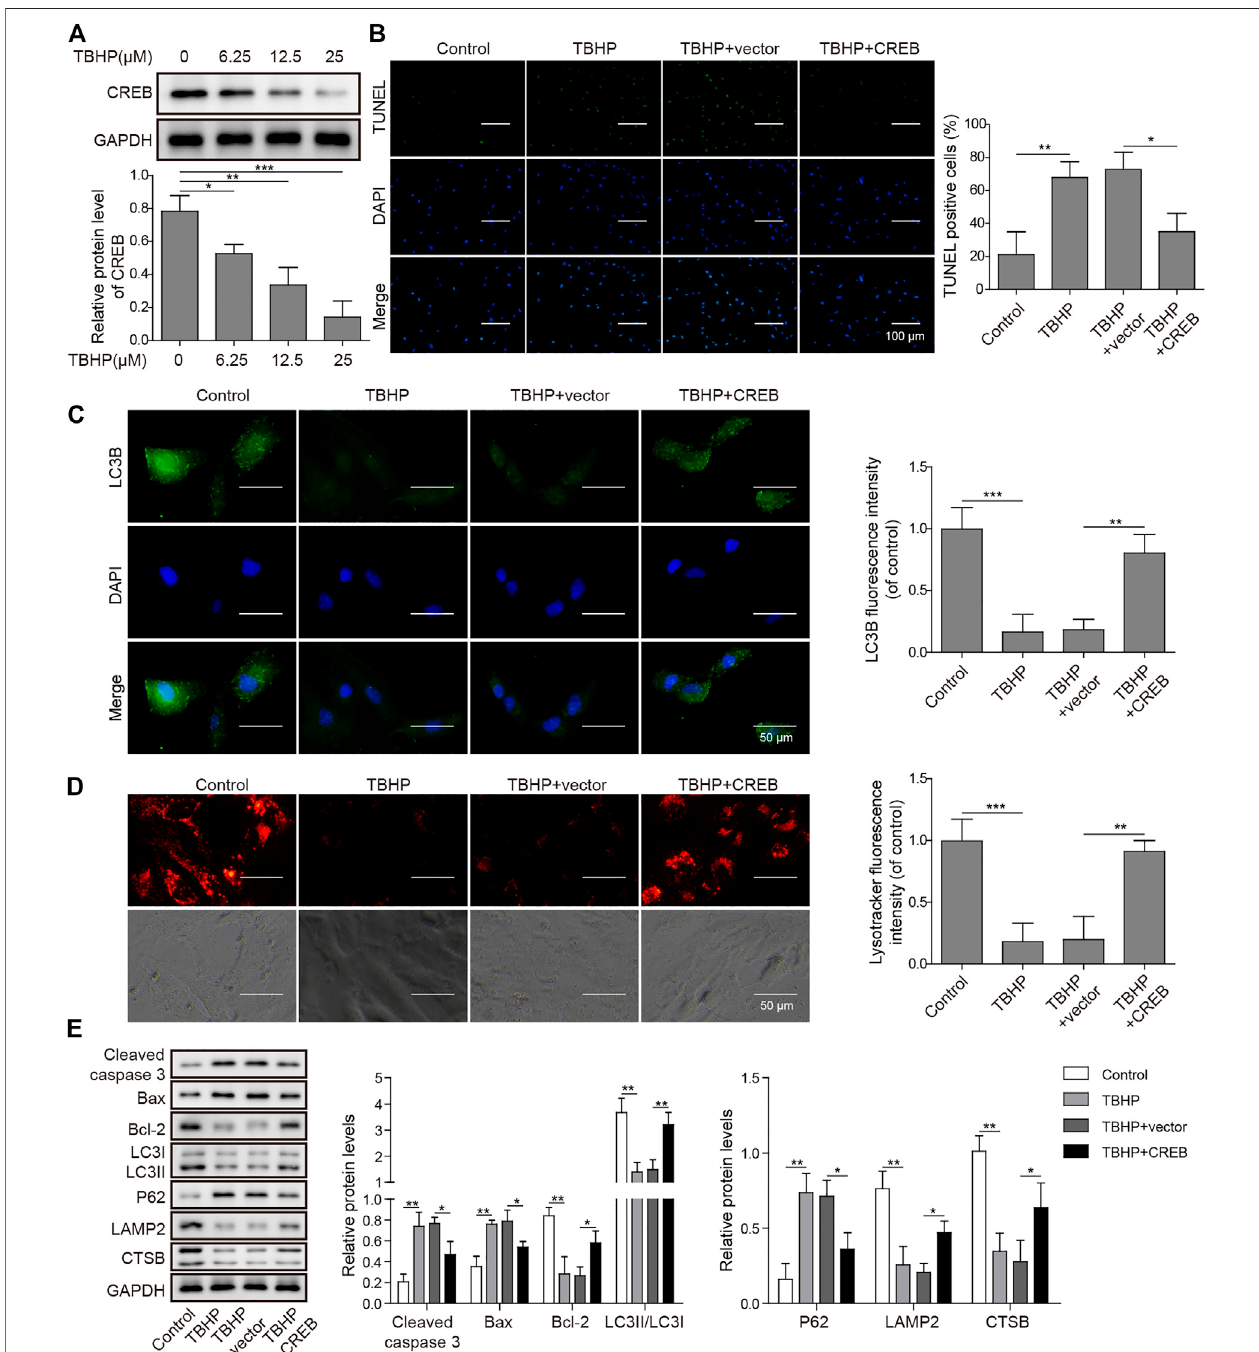
FIGURE 2 | Overexpression of CREB-attenuated TBHP-induced apoptosis and blockage of autophagic fl ux in cultured human chondrocytes. (A) The change in CREB protein under different dosages of TBHP (0, 6.25, 12.5, and 25 μ M) was determined by Western blotting and then the intensity of bands was quanti fi ed. (B) The apoptosiscausedbyeitherTBHPaloneortogetherwithCREBoverexpressionwasdeterminedbyTUNELassay.TheemptyvectorinthesameconcentrationasCREB- overexpression plasmids was used as a control. TUNEL-positive cells were counted to quantify the outcome of each treatment. (C) The autophagic fl ux under treatments of either TBHP alone or together with CREB overexpression was determined by the immunocyto- fl uorescence staining of autophagosome marker LC3B. LC3B fl uorescence intensitywasmeasured and datafrom all groups were normalized tothe control group. (D) The change oflysosome activity under treatmentsabove was determined by LysoTracker staining. LysoTracker fl uorescence intensity was measured and data from all groups were normalized to the control group. (E) The impact ofthetreatmentsontheessentialmarkersofapoptosisandautolysosomewasdeterminedbyWesternblotting.Quanti fi edintensityofthebandswasnormalized to GAPDH to generate the column chart. p < 0.05 was marked as *, p < 0.01 was marked as **, p < 0.001 was marked as ***.